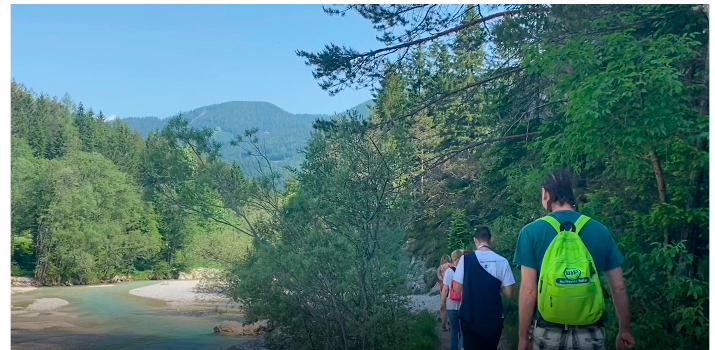
Figure 6. Forest therapy sessions conducted by an ANFT-certificated guide.